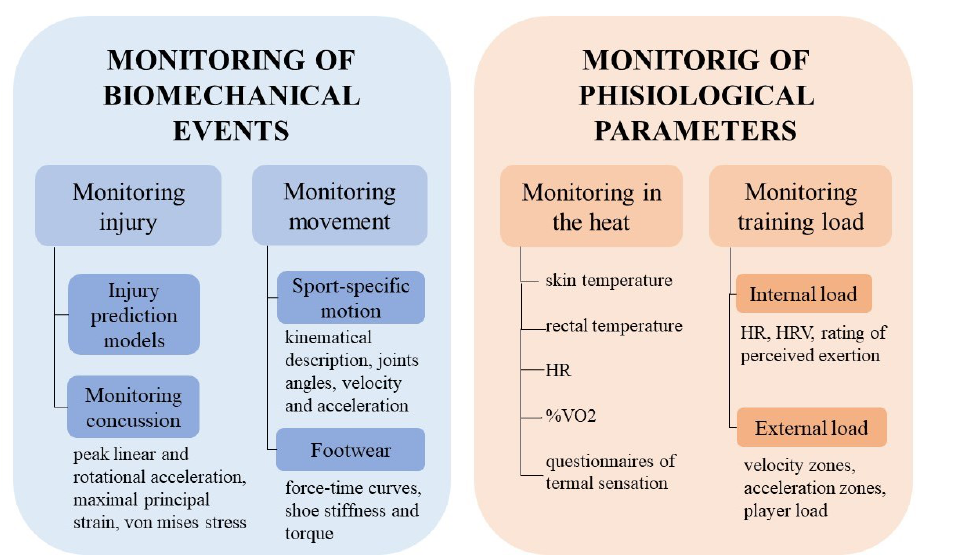
Figure 4. Summary of the topics and the typical parameters used for each topic.